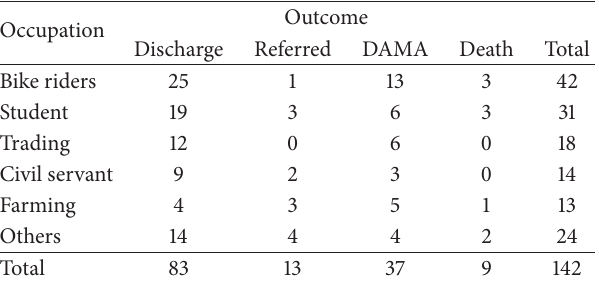
Table 2: Cross table of occupation and